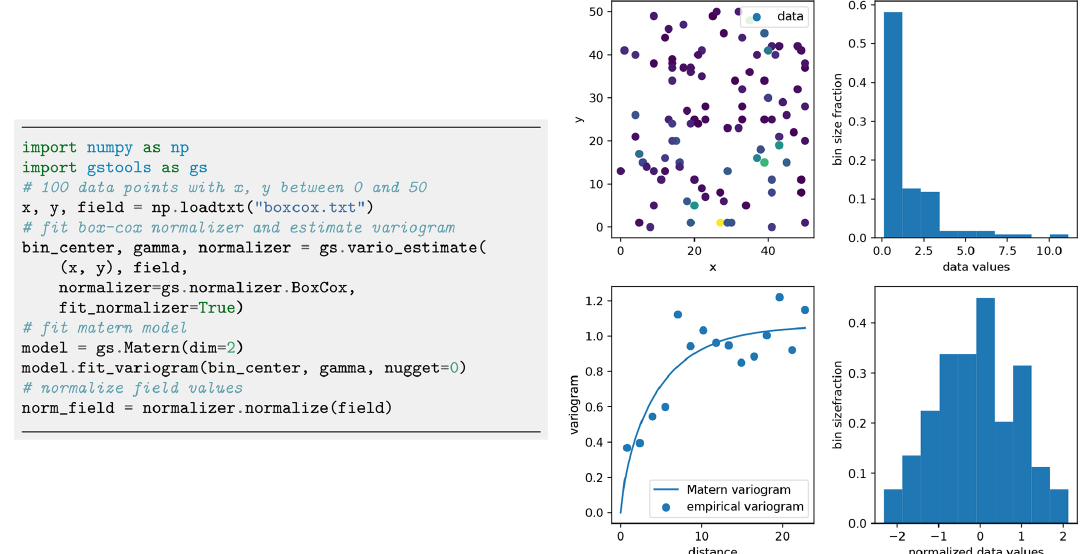
Figure 7. Estimating an empirical variogram (bottom left) of synthetic unstructured data (top left) after Box–Cox normalization of skewed input values. Panels on the right show the histogram of the data values before (top) and after (bottom) the normalization. For demonstration purposes, a Matern model was fitted to the empirical variogram. Plotting commands have been